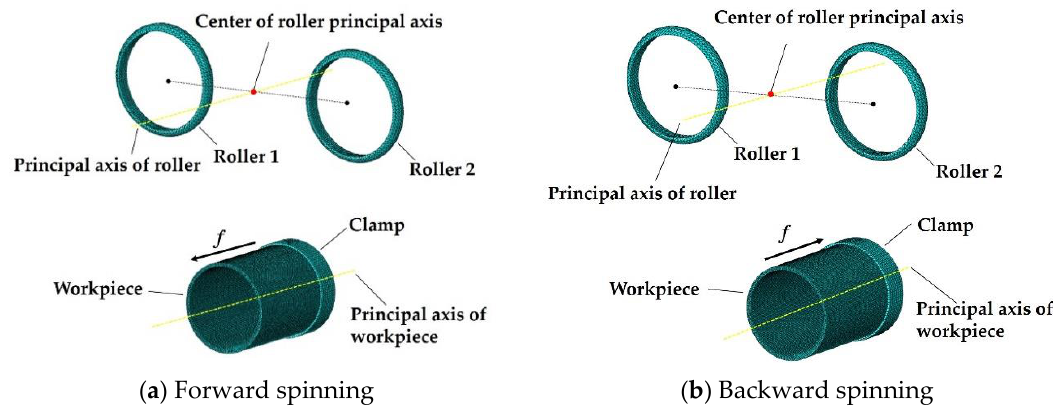
Figure 1. Finite element model of the novel non-circular spinning method.